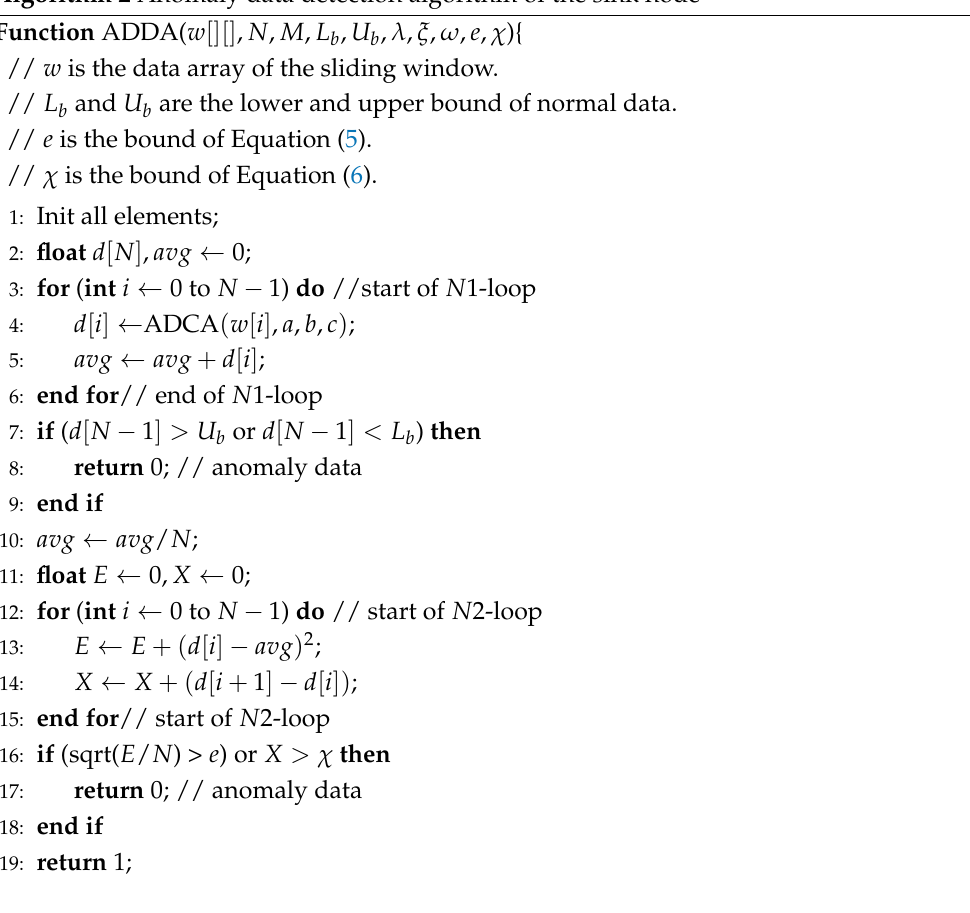
Algorithm 2 Anomaly data detection algorithm of the sink